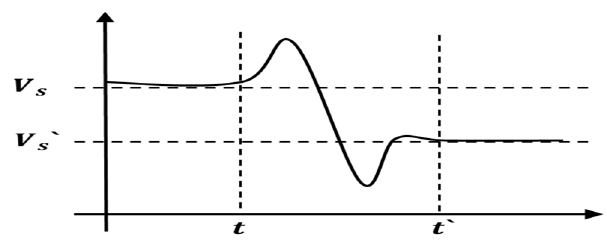
Figure 5. Concept of Vs’ and time t’.